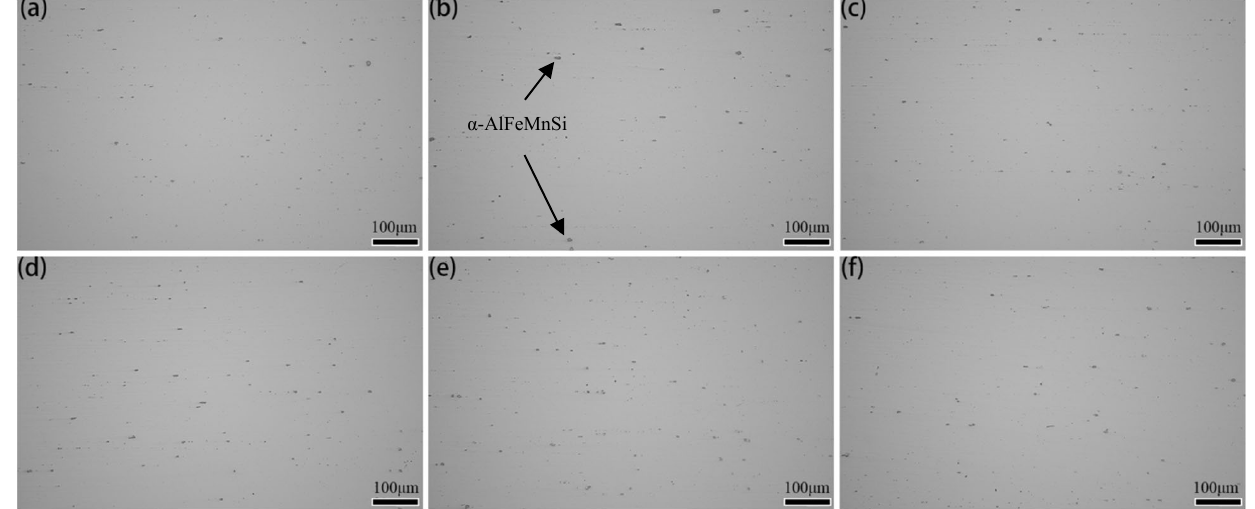
Figure 2. Optical microscopy (OM) images of 7005 aluminum alloy plates aged at 120 °C for different durations (along the longitudinal section, non-etched): ( a ) 1 h, ( b ) 4 h, ( c ) 12 h, ( d ) 24 h, ( e ) 96 h, and ( f ) 192 h.